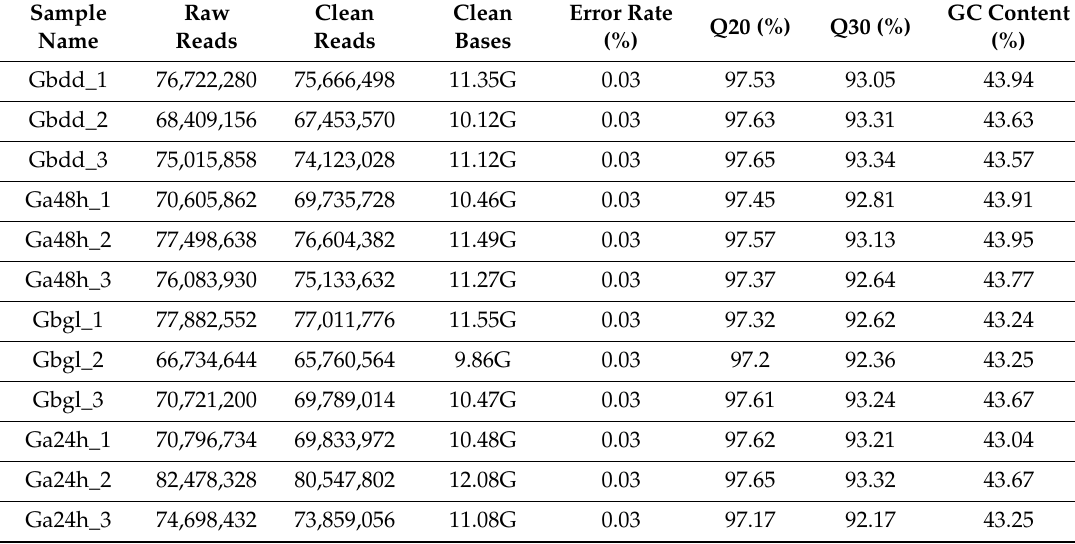
Table 1. Summary of 12 separately pooled RNA sequencing read counts, using Gossypium arboreum genome as a reference